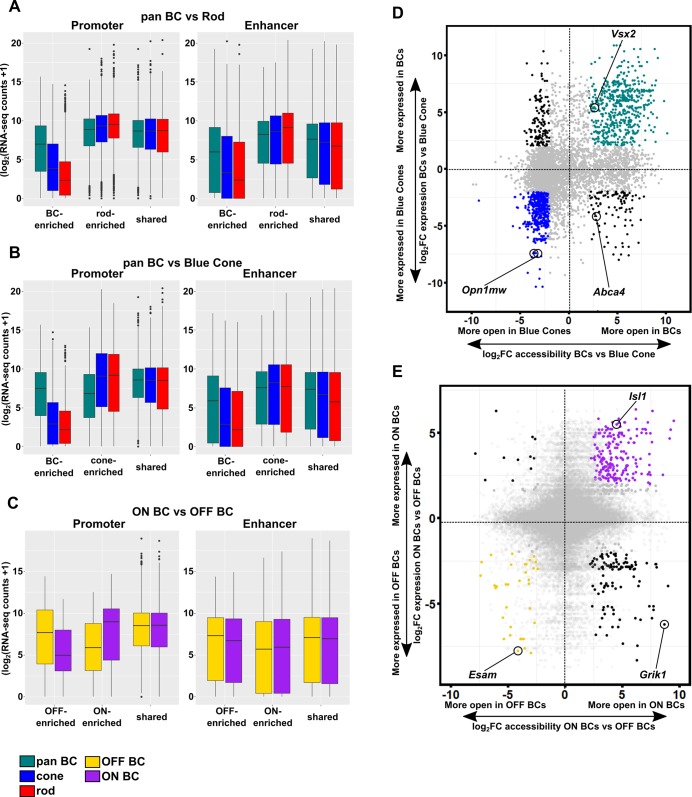
Correlation between chromatin accessibility and expression of associated genes.(A–C) Differentially accessible ATAC-seq peaks defined as promoters (left) or enhancers (right) were mapped to genes based on proximity to the nearest TSS. Boxplots show RNA-seq expression data for genes associated with peaks that are differentially accessible in (A) pan BC vs rod, (B) pan BC vs blue cone, and (C) ON bipolar cells vs OFF bipolar cells. (D–E) Scatterplots as in Figure 5C comparing chromatin accessibility and associated gene expression of ATAC-seq peaks in bipolar cells versus blue cones (D), and in ON versus OFF bipolar cells (E). Peaks with four-fold greater chromatin accessibility and associated gene expression (FDR < 0.05) are colored for each tissue: bipolar cells in green (n = 542), blue cones in blue (n = 505), ON-bipolar cells in purple (n = 203), and OFF-bipolar cells in gold (n = 34). Shared peaks and those with less than four-fold differences in associated gene expression are shown in gray, while those with discordant accessibility and associated gene expression are shown in black. Peaks in panel D are those identified in Figure 5A, while those in panel E are the sum of peaks identified in ON and OFF bipolar cells. Individual peaks and their assigned genes are indicated for reference.